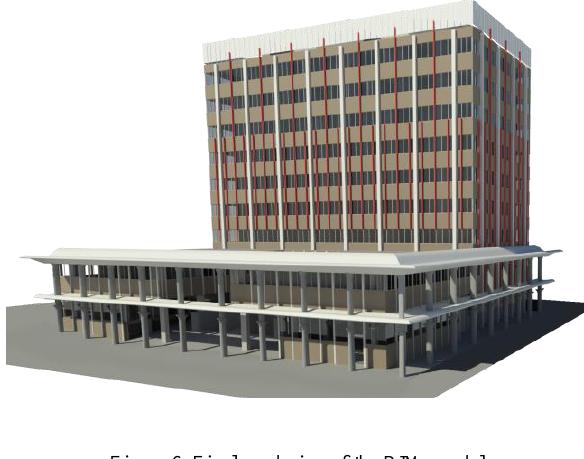
Figure 6. Final rendering of the BIM